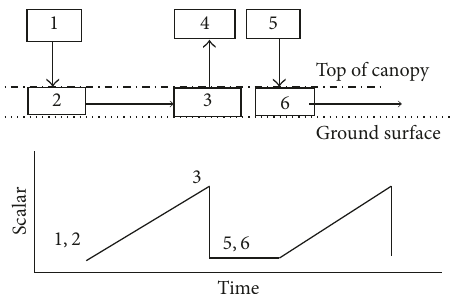
Figure 1: Development of ramps under unstable conditions trav- eling on an air parcel and the parcel is warmed by plant canopy elements